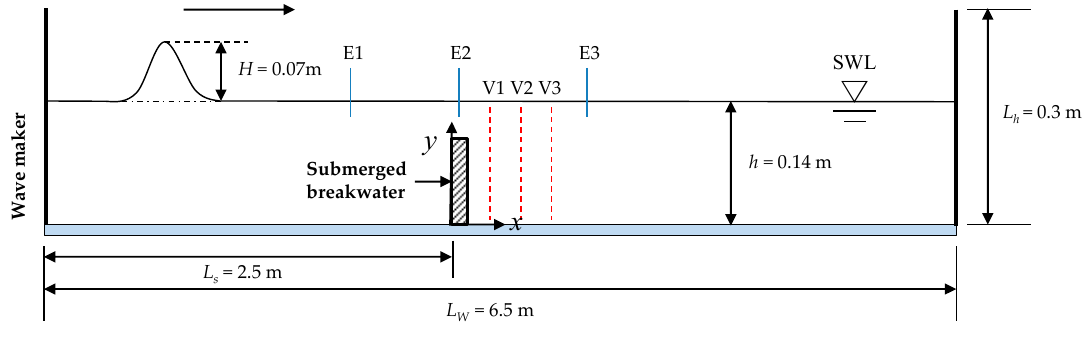
Figure 1. Schematic view of the solitary wave propagating over a submerged breakwater.